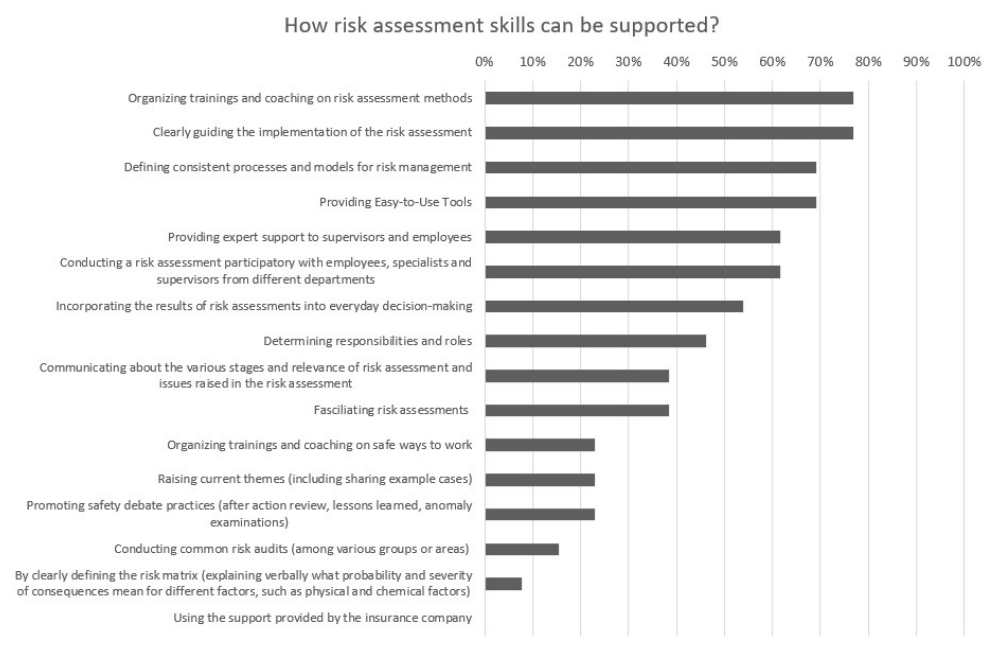
Figure 4. Opinions of occupational health specialists and managers for the most feasible ways to support risk assessment